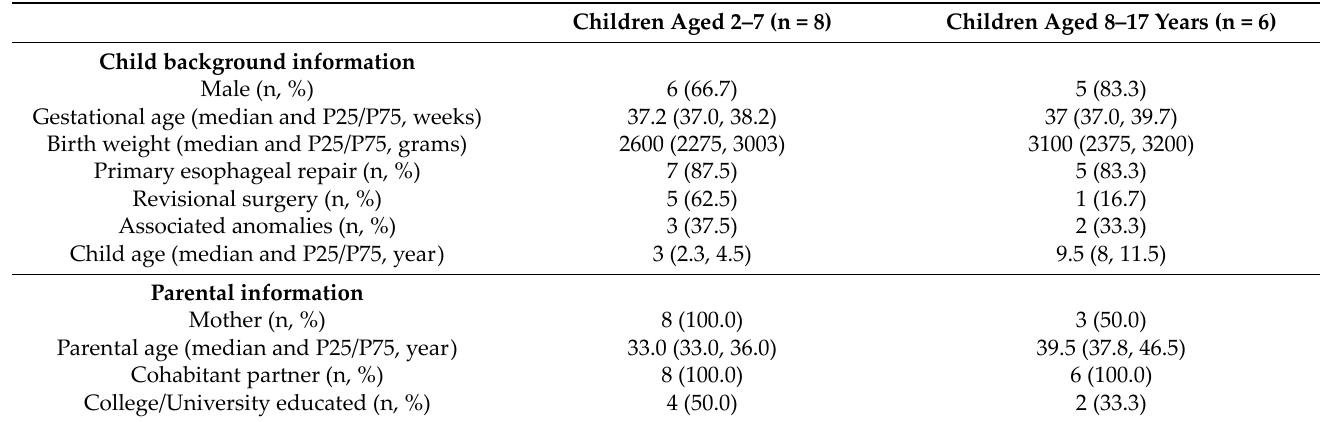
Table 3. Presentation of families responding to the EA‑QOL questionnaires for children aged 2–7 and for children aged 8–17 (n =